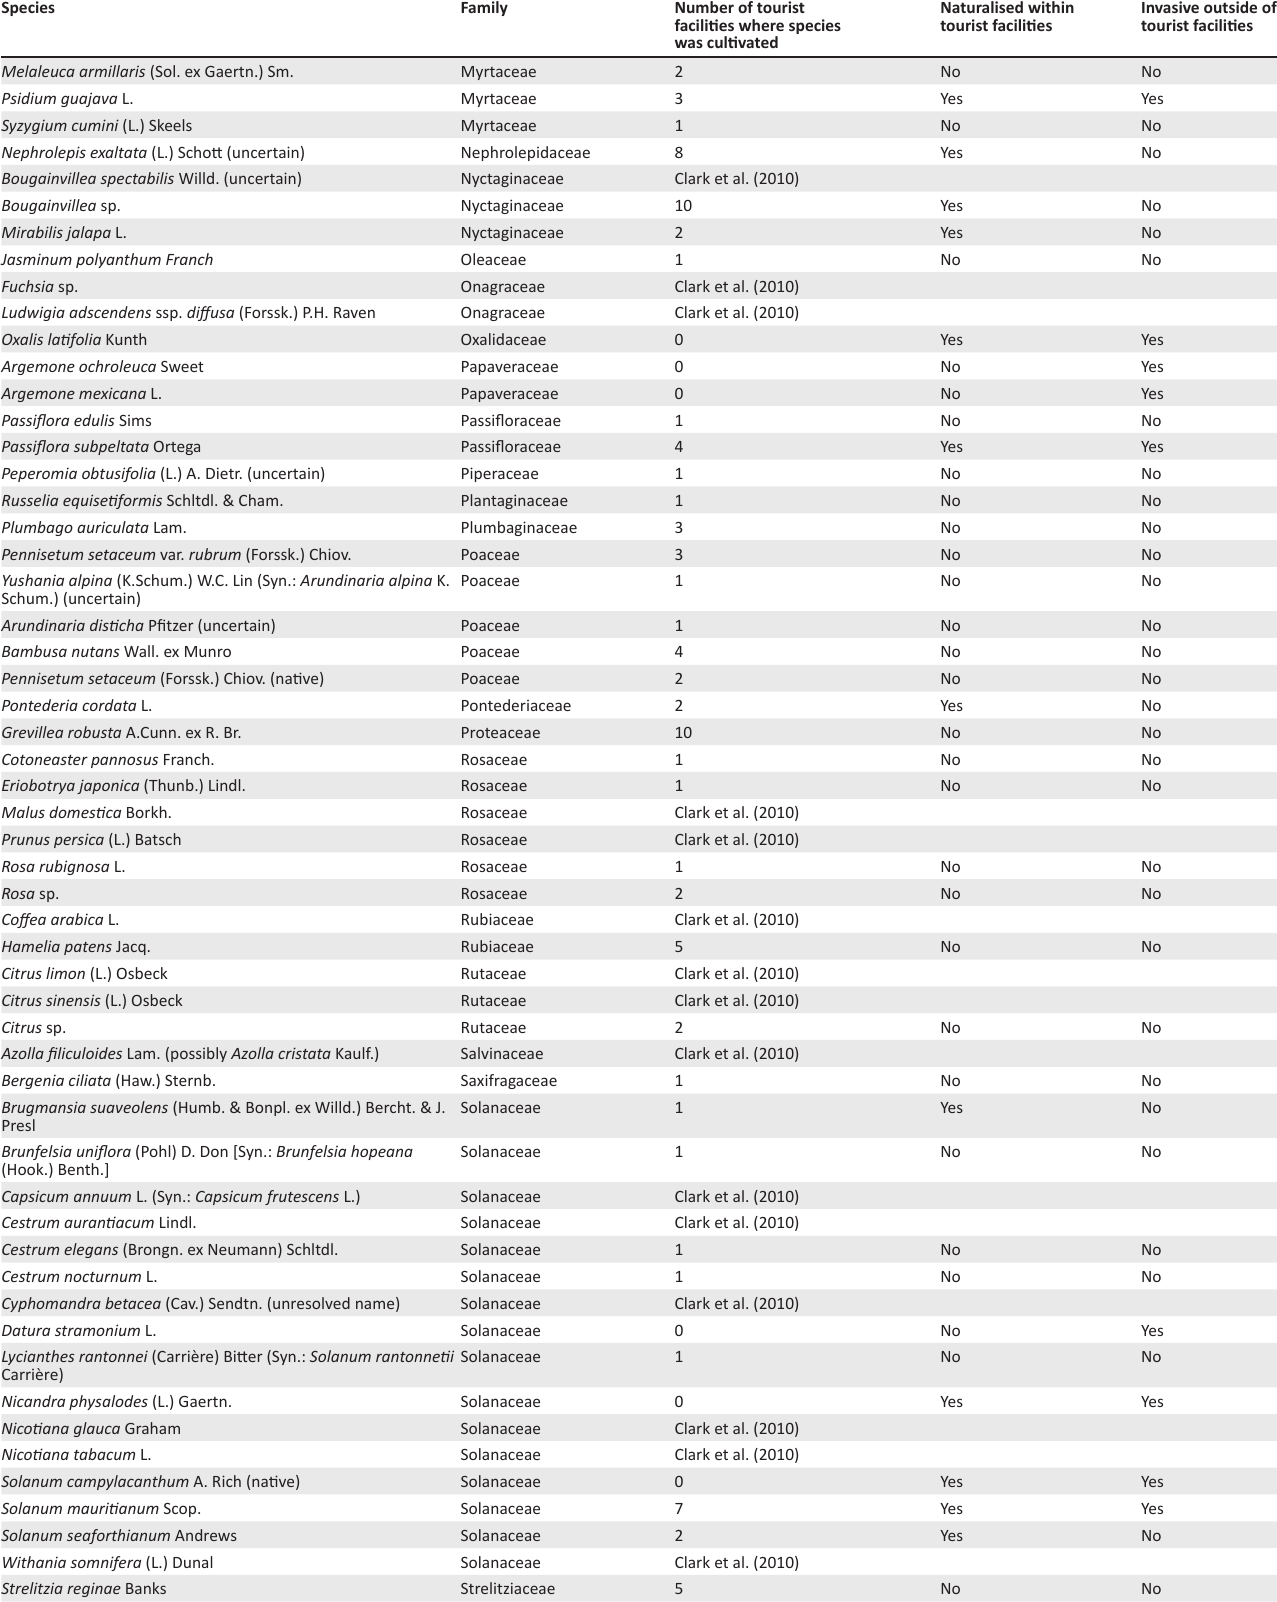
TABLE 1: (Continues...) Alien plant species, including some native plant species which may be growing outside of their natural range, recorded in the Serengeti-Mara ecosystem and immediate surrounds (excluding vegetable crops and grains).